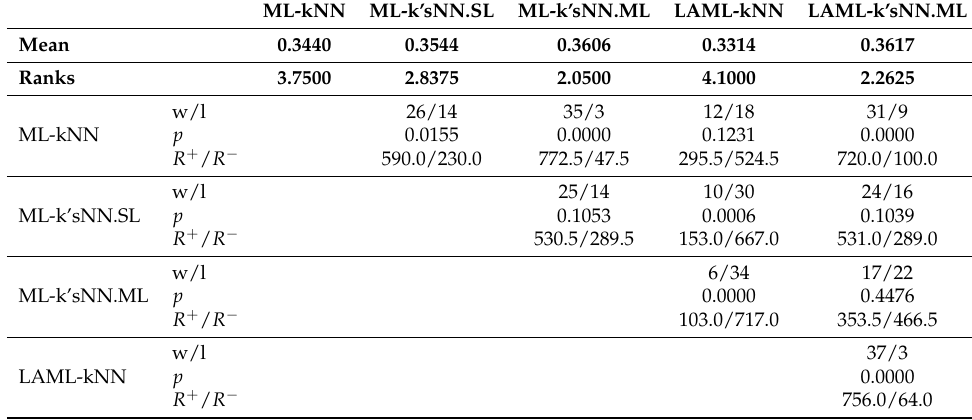
Figure 1. Results of ML-kNN and ML-k’sNN for the four metrics: accuracy, F1, F1-macro and F1-micro. Table 2. Comparison of the different methods using accuracy